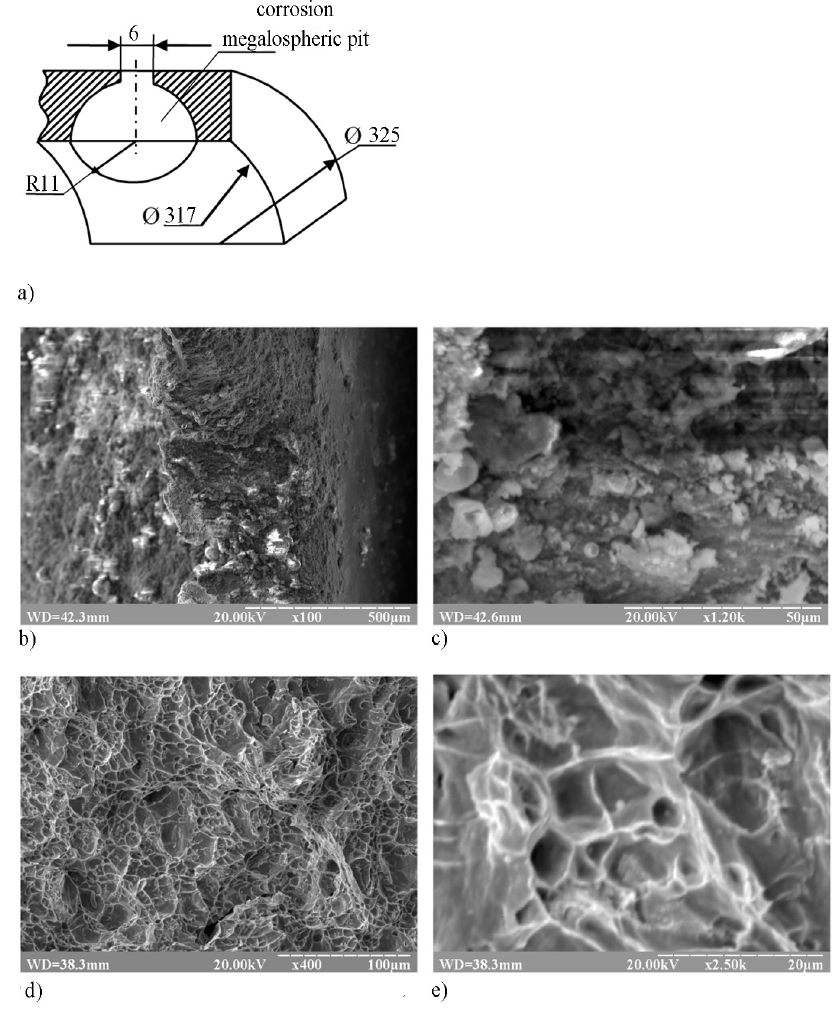
Fig. 4. Scheme (a) and the surface of the corrosion of a semispherical hole (b, c) and the surface of static failure of the pipe material (d,